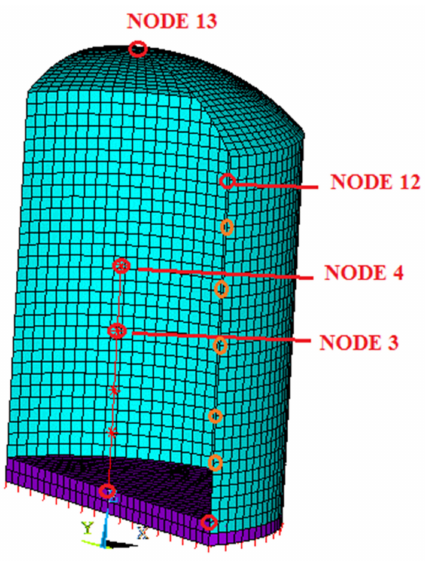
Figure 4. Finite element model of a nuclear reactor building.